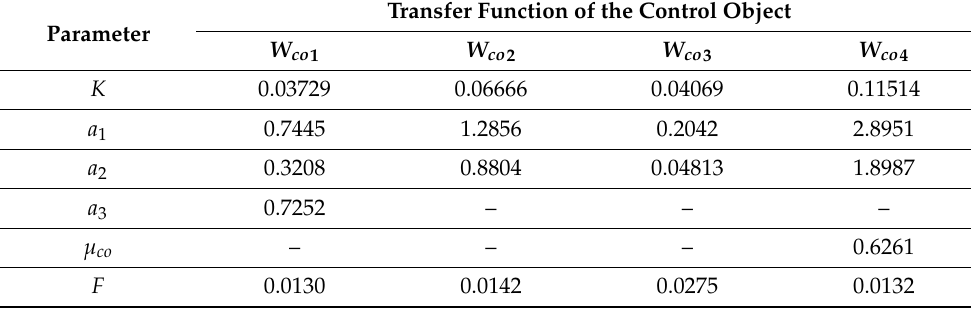
Table 1. Results of identification of the control